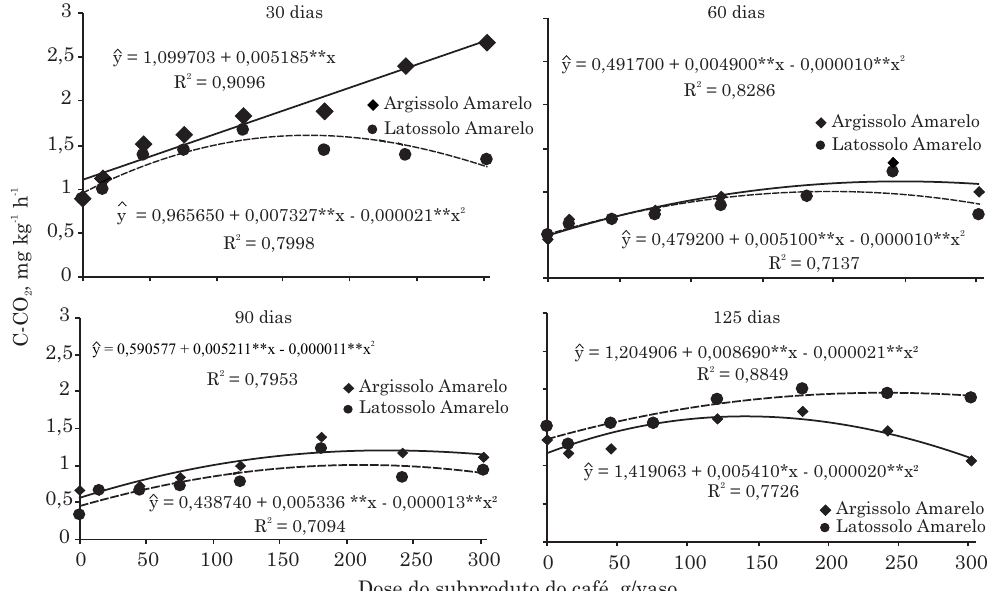
Figura 2. Respiração microbiana (C-CO 2 ) aos 30, 60, 90 e 125 dias de incubação nas amostras do Argissolo Amarelo e Latossolo Amarelo, em função da aplicação de doses de subproduto de café e sob o cultivo de